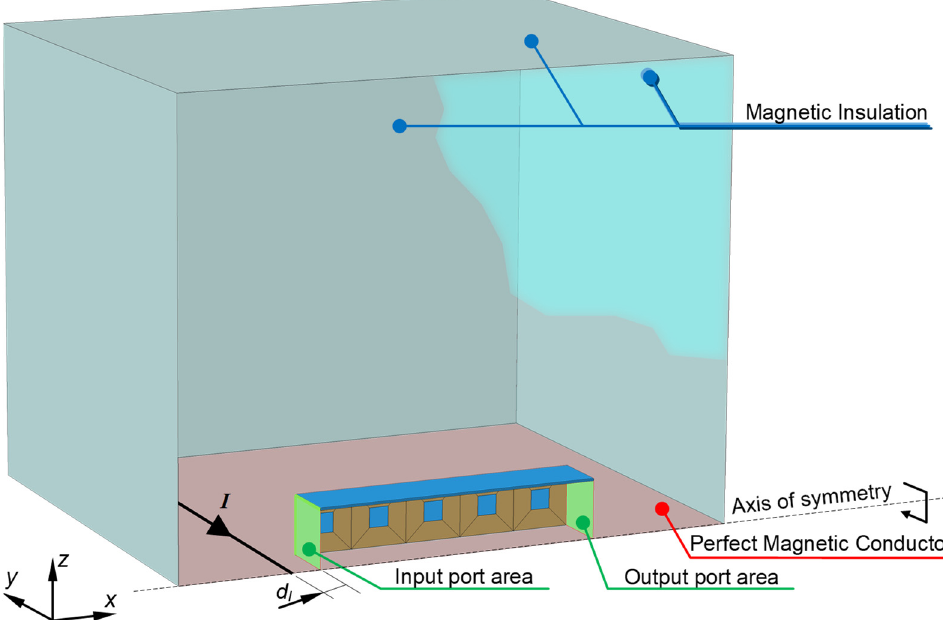
Figure 3. Numerical model of the magnetic meta-hose with a line conductor as the source of the magnetic field. The model was analyzed as a quarter of the original structure, and symmetry conditions were applied on the external xz and xy surfaces.